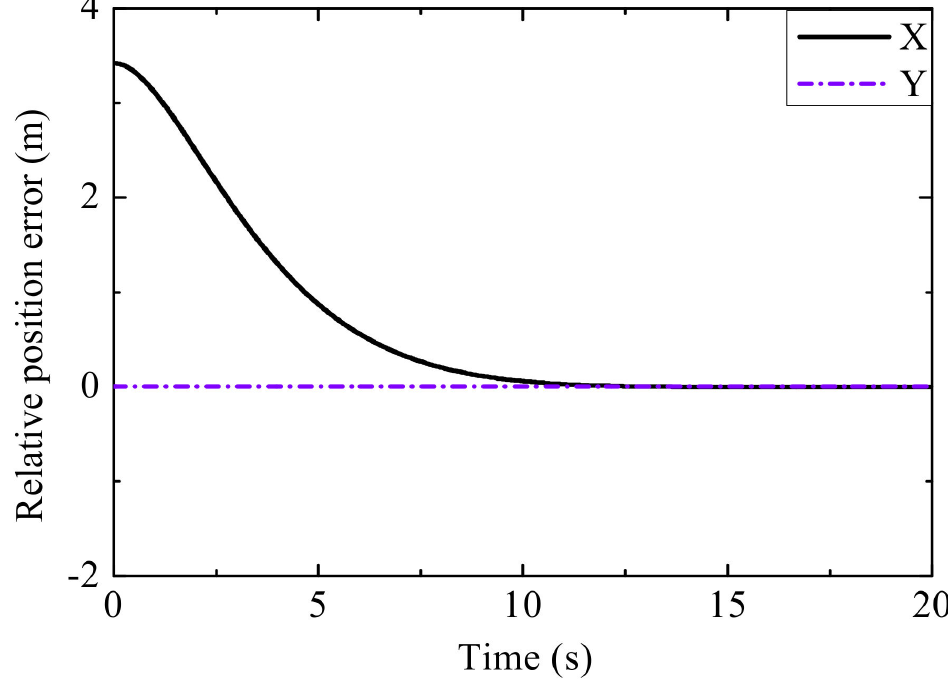
Figure 15. Relative position between two virtual points in the preassembly